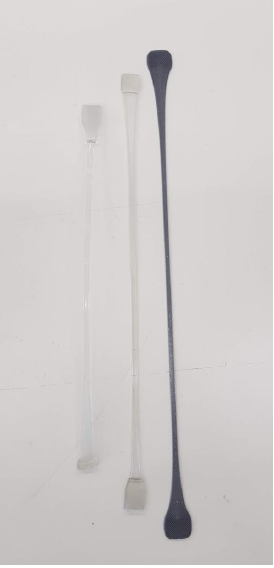
Figure 10. Injection moulded tensile bars were hot drawn ~5 × at 100 ◦ C and heat set at 170 ◦ C under tension. The two transparent samples are amorphous PET after drawing to two different draw ratios, and crystallizing under tension. The grey sample is a 3 vol. % Al 2-PET, also drawn and crystallized under tension. Table 10. Notched Izod Impact resistance in J / m, of amorphous PET and Al 2 / Amorphous PET composites. Std. Dev. is the standard deviation. N is the number of